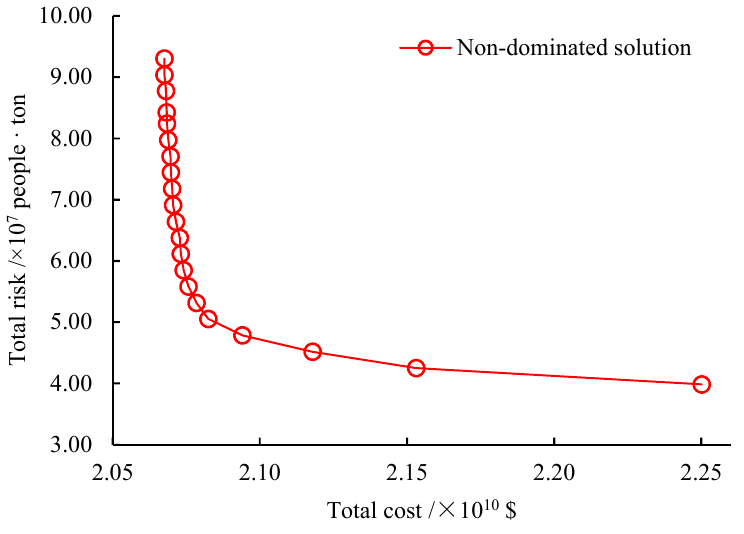
Figure 3. Approximated non-dominated